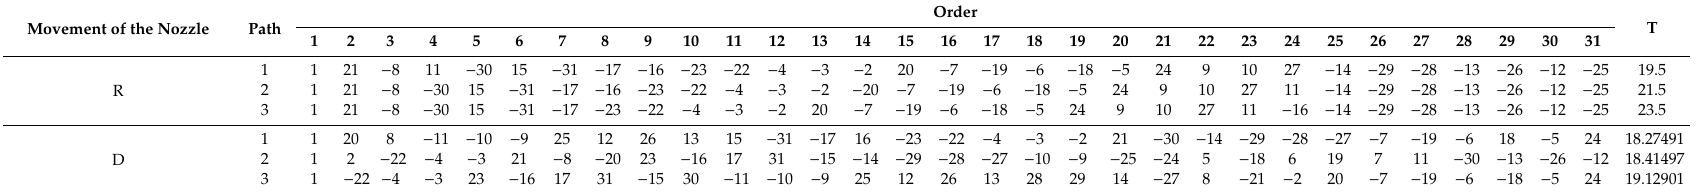
Table 11. Best solutions obtained for a 31-wall